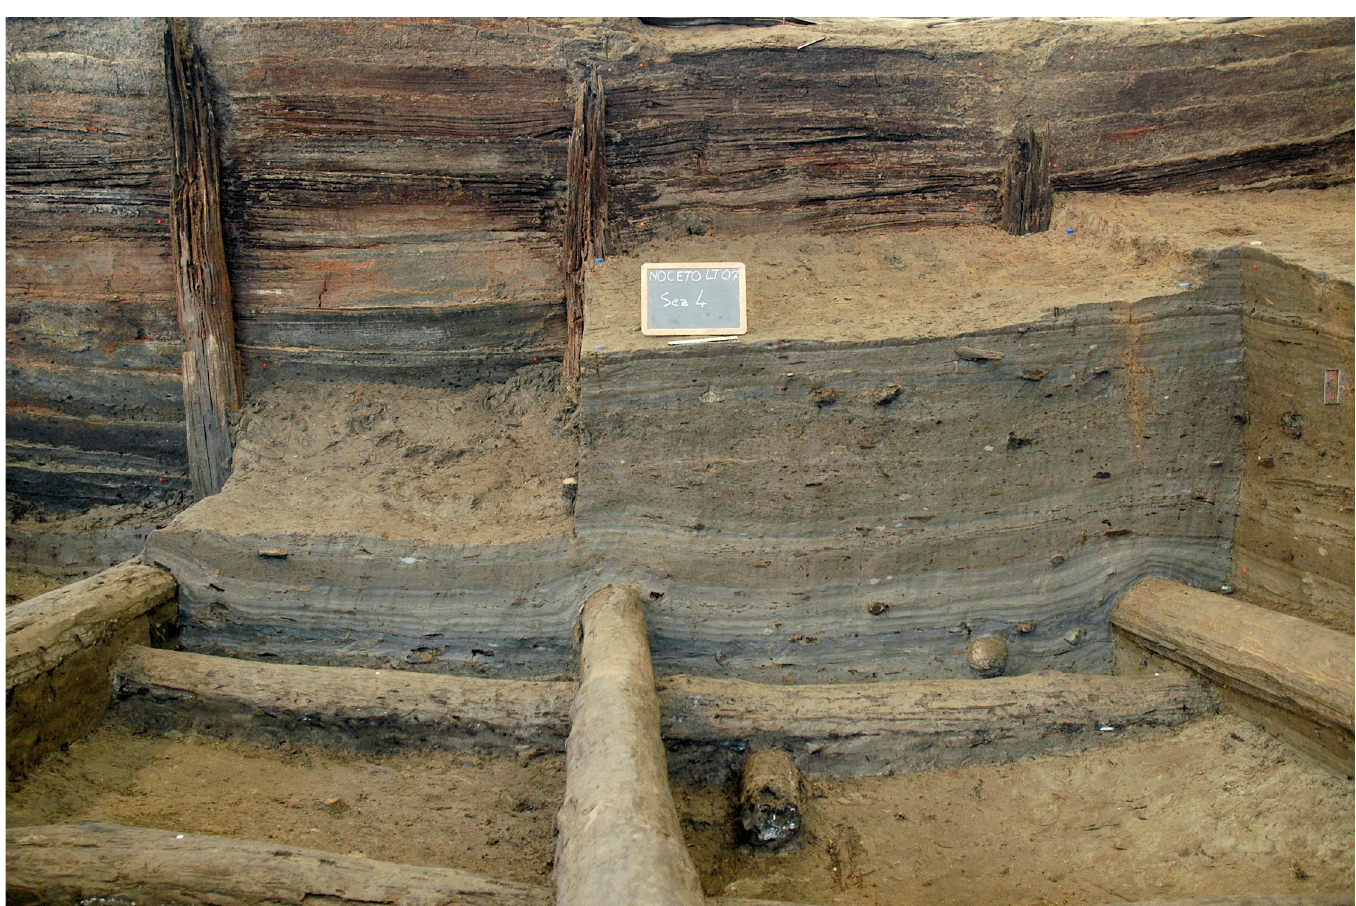
Fig 6. The fill of the upper tank at Noceto showing the laminated deposits lying upon the beams placed at the base of the structure.